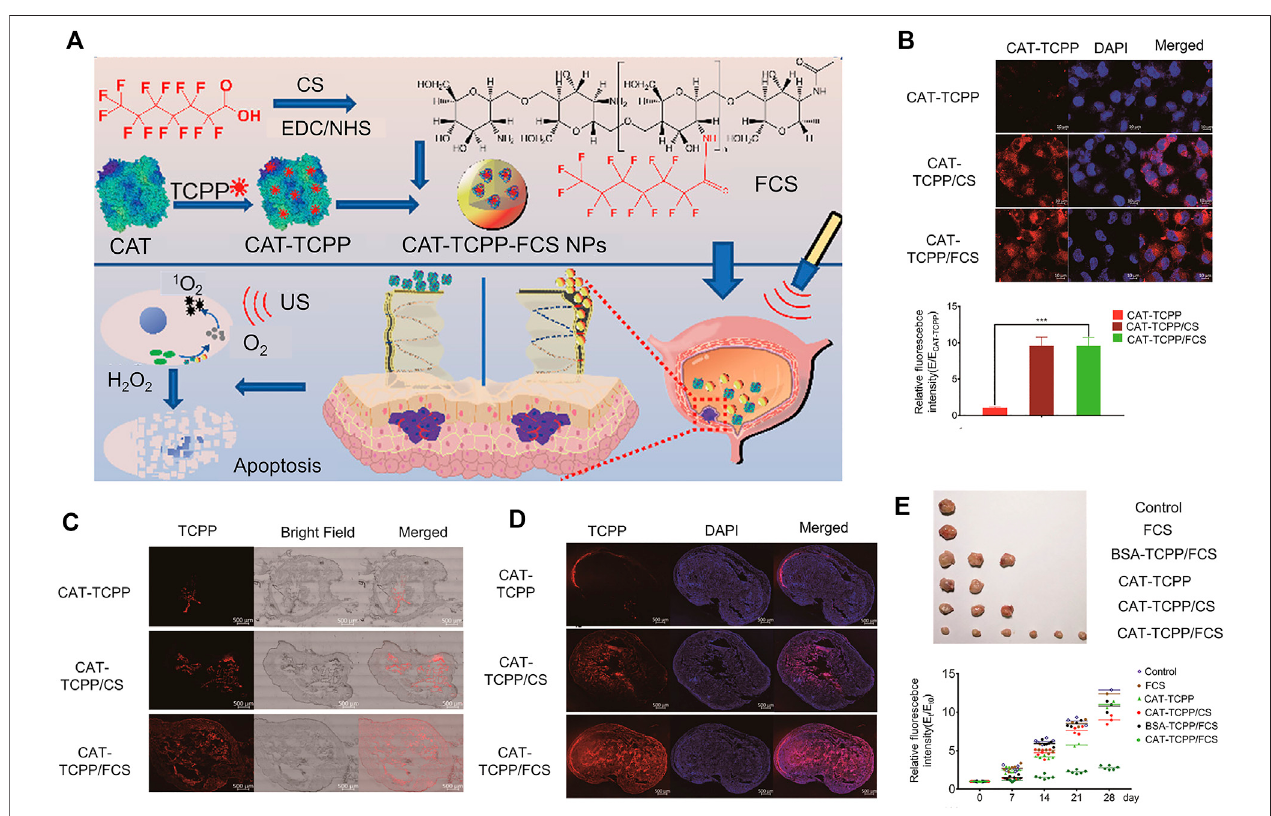
FIGURE 3 | Fluorinated chitosan as a nano-delivery carrier of catalase for sonodynamic BC therapy post intravesical instillation. (A) Schematic diagram of preparation,characterizationandintravesicalinstillationofCAT-TCPP/FCSNPs. (B) Confocal fl uorescenceimagesofMB49cellstreatedwithdifferentnanoparticles. (C) Confocal fl uorescence images of frozen sections of bladder treated with different nanoparticles for 12 h. (D) Confocal fl uorescence images of mouse bladder cancer sections after intravesical instillation with different nanoparticles for 1 h. (E) Image of mouse bladder removed after the experiment and relative bioluminescence signal intensities following different treatments. Reproduced with permission from (Li et al.,